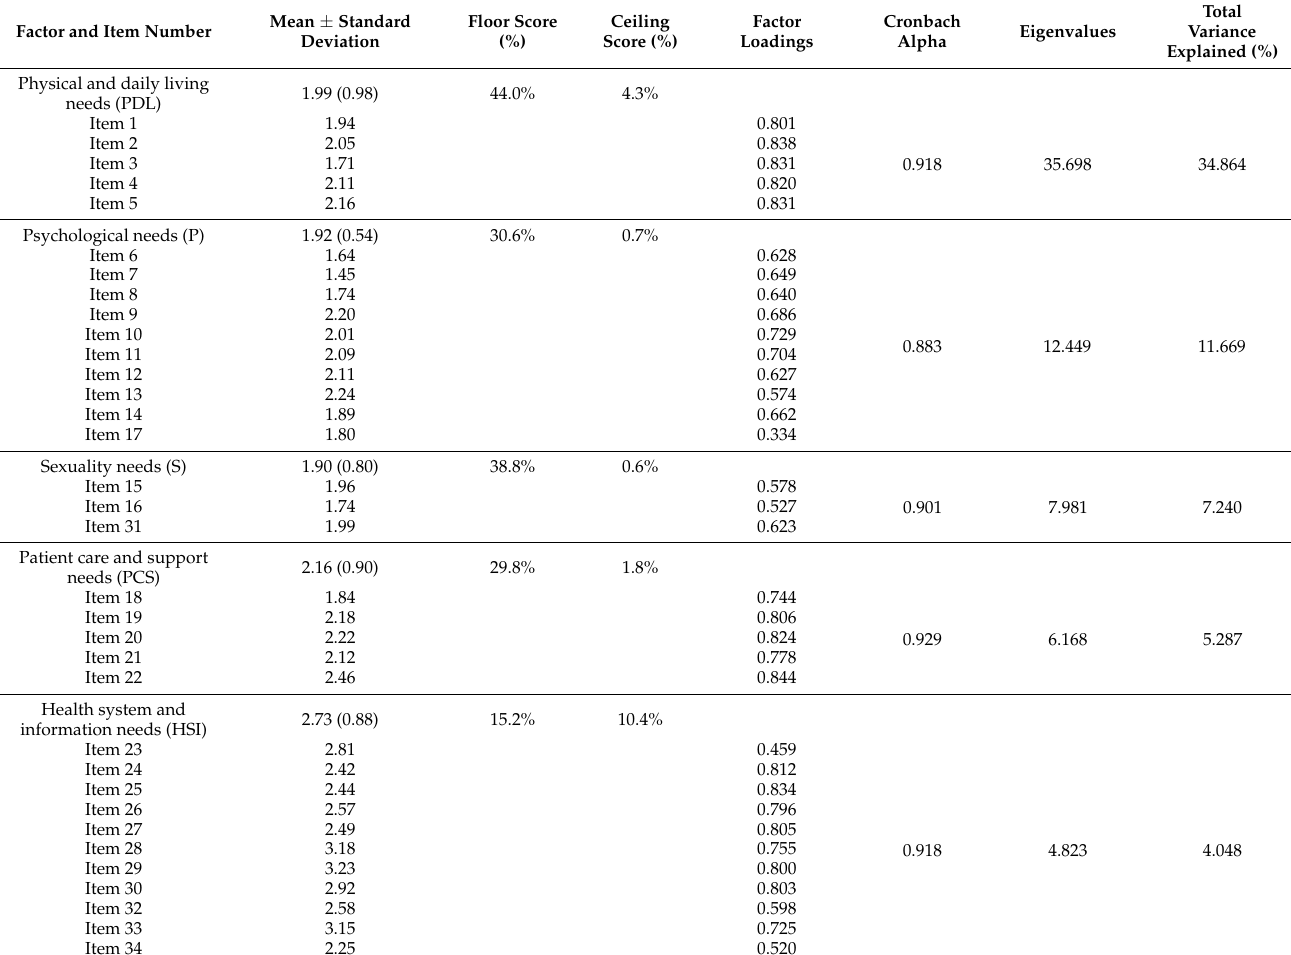
Table 2. SCNS-SF34 Malay items (mean and standard deviation) and factor loadings in exploratory factor analysis ( n =